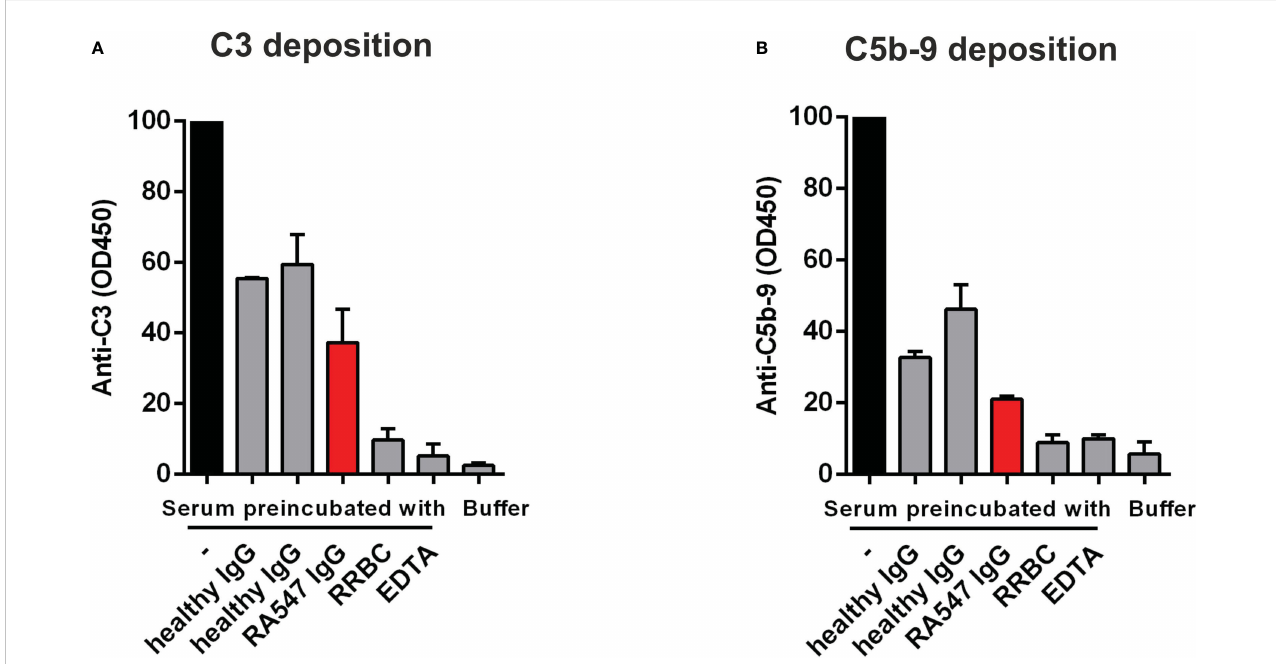
FIGURE 6 Anti-FB autoantibodies decrease complement activation-derived deposition of C3 and C5b-9 on LPS-coated surface. Normal human serum was preincubated with PBS, patient- or healthy control-derived IgG, and RRBC as a positive control, then added to LPS-coated wells. EDTA was used to inhibit complement activation on LPS. The deposition of (A) C3 and (B) C5b-9 was detected with anti-C3 and anti-C5b-9 antibodies, respectively. Data are mean ± SD from two independent experiments. RRBC: Rabbit Red Blood